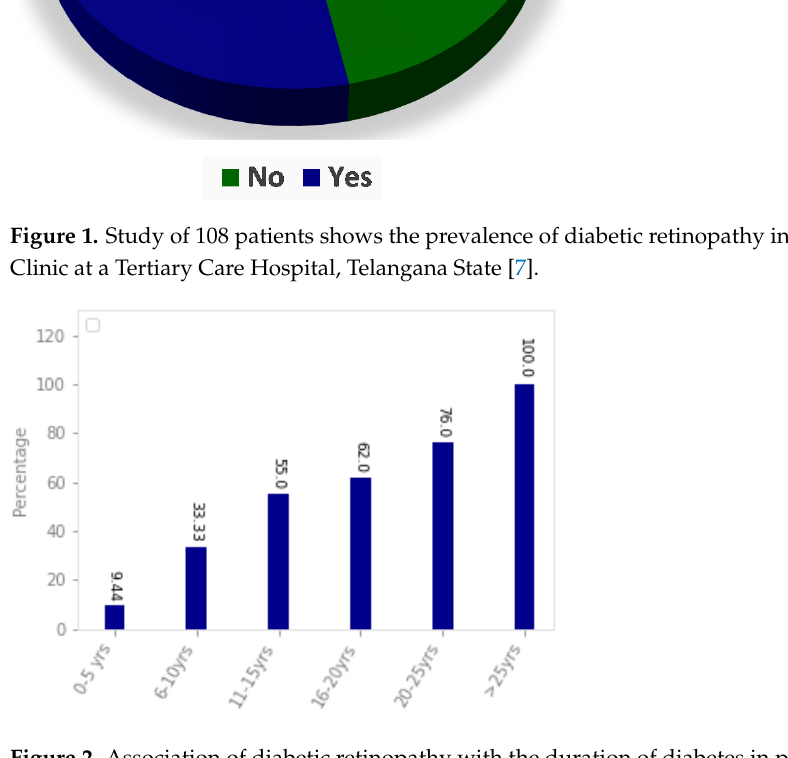
Figure 2. Association of diabetic retinopathy with the duration of diabetes in patients